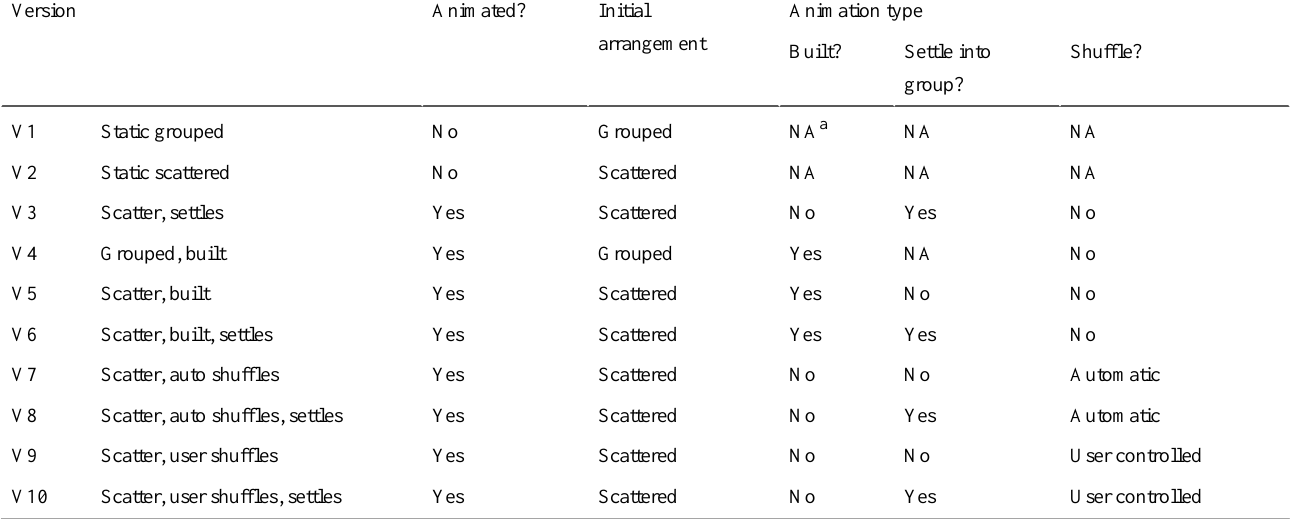
Table 1. Experimental